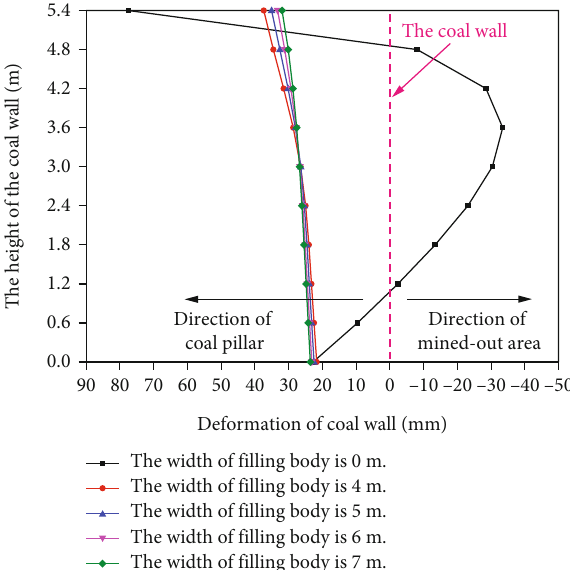
Figure 14: The coal wall deformation at the side of the stopping mining coal pillar in the retracement